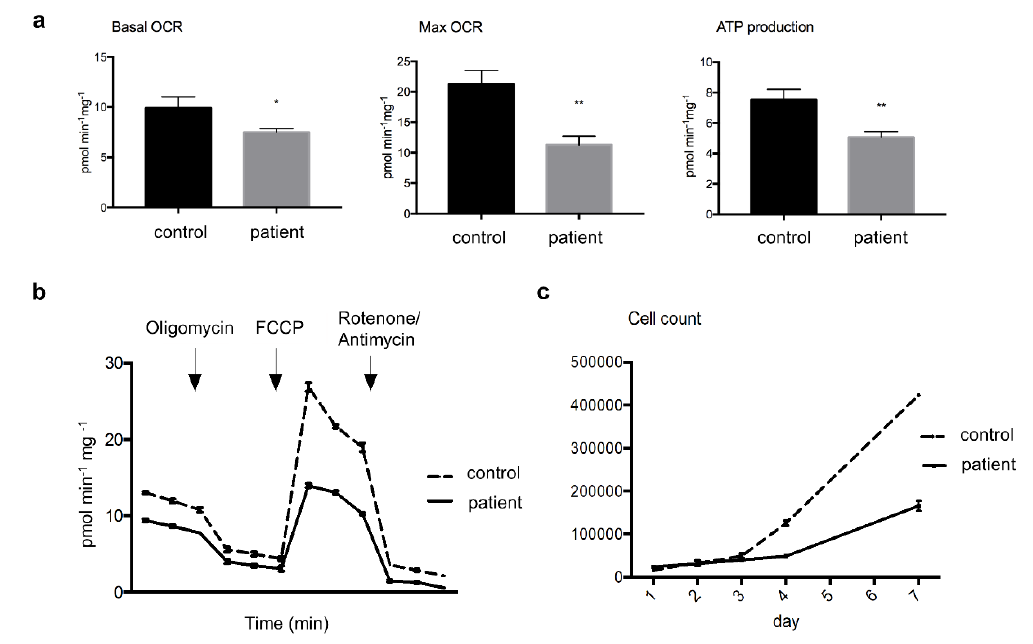
Figure 2. Oxygen consumption rates (OCR) and cell growth in cultured skin fibroblast . Panel ( a ) showing significantly lower levels of basal and maximal OCR (Mann–Whitney U -test, * p < 0.05, and ** p < 0.01, respectively), as well as of ATP production rate (** p < 0.01) in the patient’s compared to control cells; Panel ( b ) a representative three-replicate analysis of OCR in an XF extracellular analyzer; Panel ( c ) displaying slower cell growth rate in patient’s cultured cells compared to control assayed for one week. Abbreviation: FCCP, carbonyl cyanide- 4 -(trifluoromethoxy) phenylhydrazone.